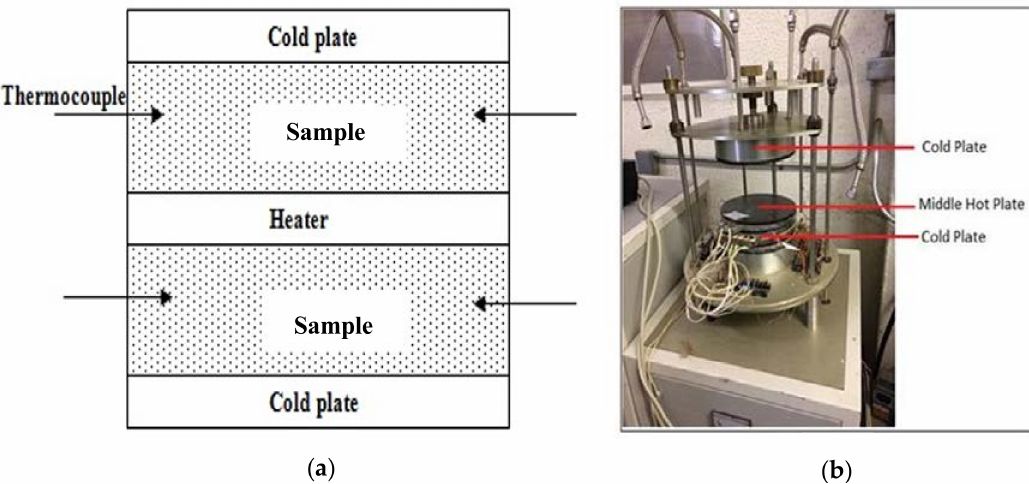
Figure 8. ( a ) Thermal conductivity testing diagram and ( b ) test